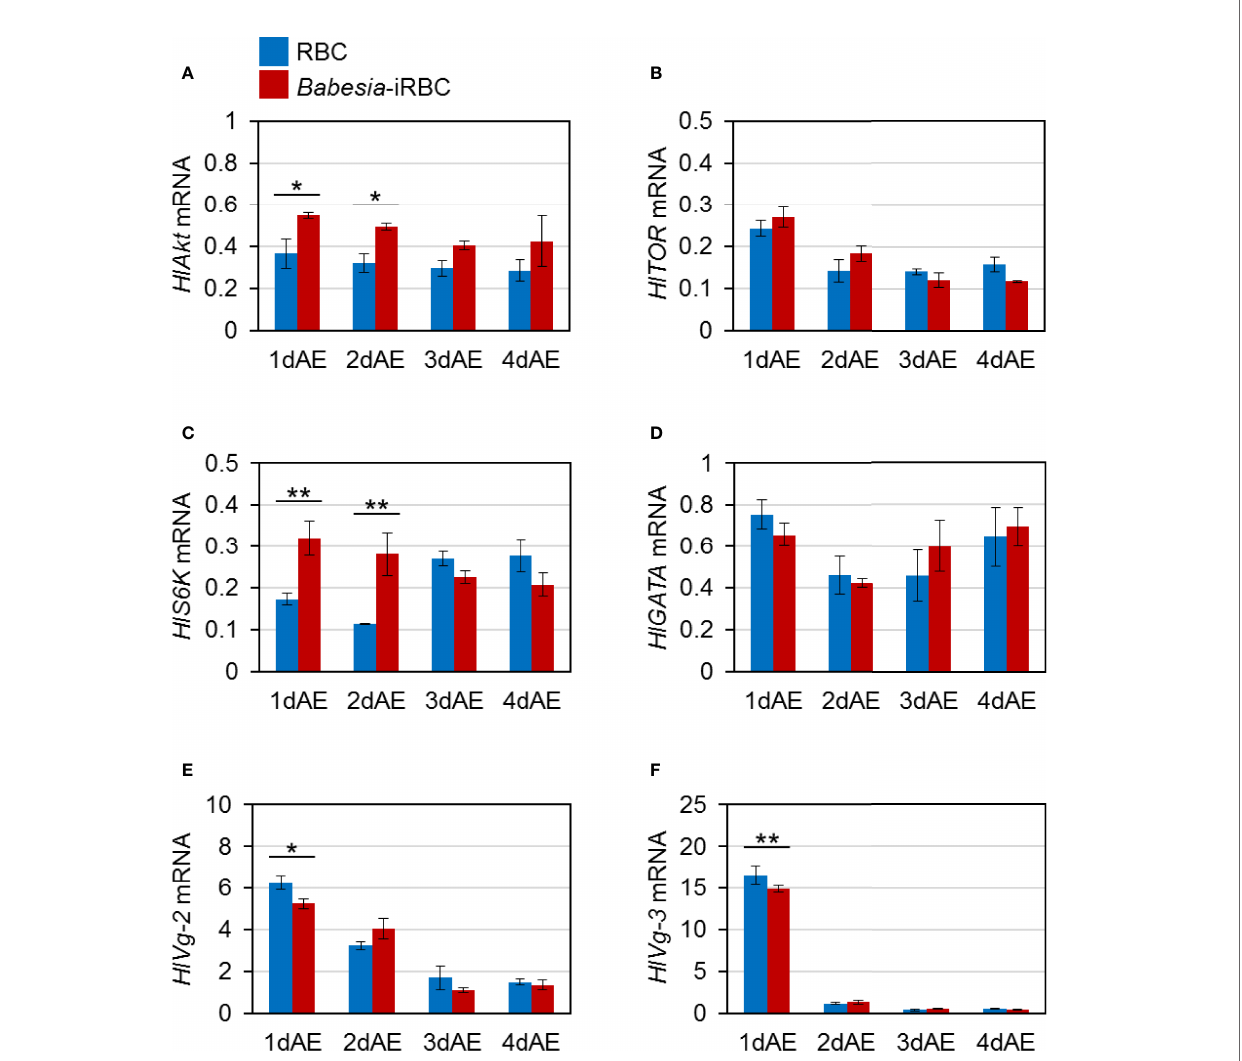
FIGURE 1 | mRNA expression analysis of (A) Akt ( HlAkt ), (B) target of rapamycin ( HlTOR ), (C) S6 kinase ( HlS6K ), (D) GATA ( HlGATA ), (E) vitellogenin-2 ( HlVg-2 ), and (F) vitellogenin-3 ( HlVg-3 ) in the fat body after semiarti fi cial mouse skin membrane feeding with bovine red blood cells (RBC group) or with Babesia -infected bovine red blood cells ( Babesia -iRBC group). Total RNA was extracted from the fat body of engorged female ticks (n = 5) 1, 2, 3, and 4 days after engorgement (1dAE- 4dAE). DNase-treated total RNA was used for cDNA synthesis. Data were normalized using HlP0 levels in the cDNA samples. Data represent the mean ± SD of triplicated samples. Asterisks indicate the signi fi cant differences between the RBC and Babesia -iRBC groups (* P < 0.05, ** P < 0.01 using the Tukey – Kramer